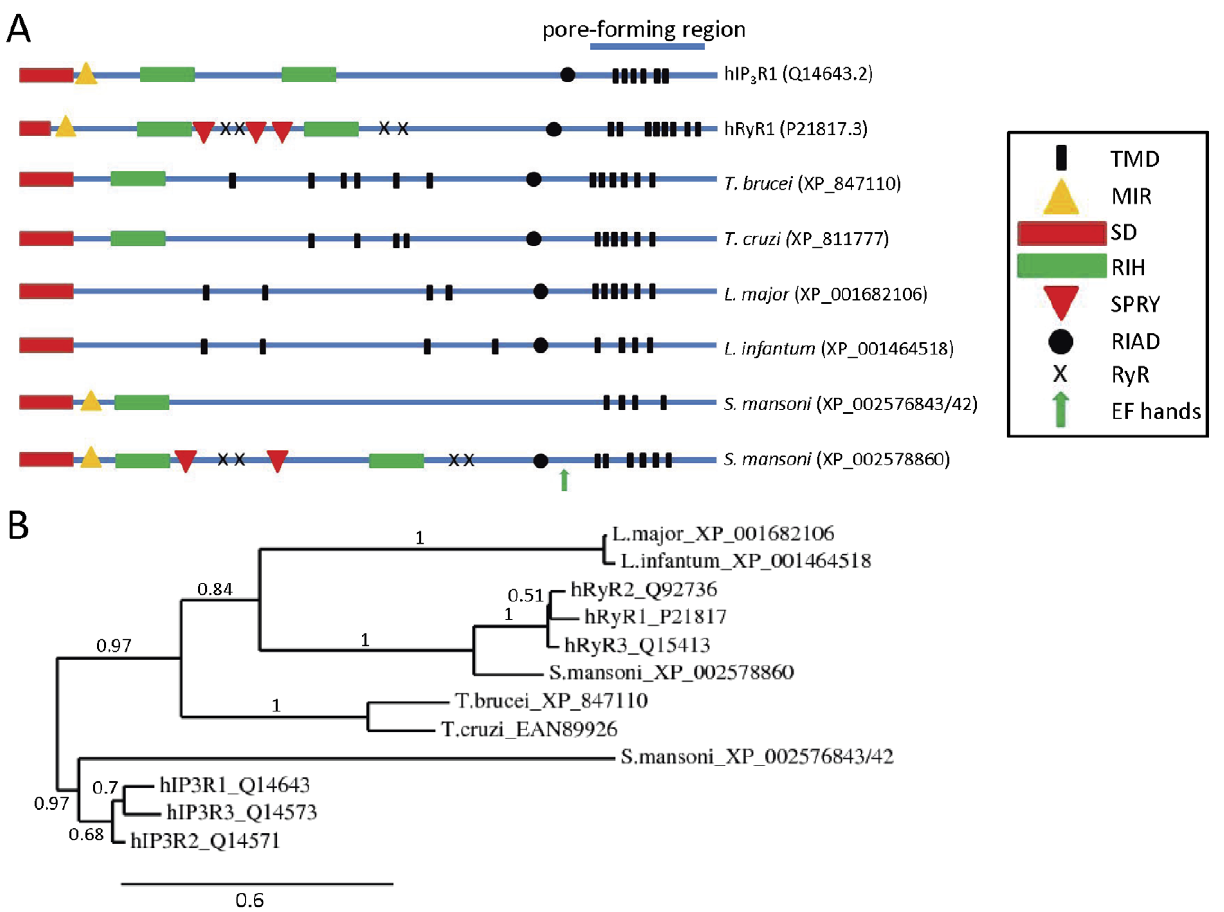
Figure 2. Comparison of full-length sequences of human and parasite IP 3 R/RyR homologues. (A) Schematic showing location of putative transmembrane domains (TMDs) and conserved domains identified using the Conserved Domains Database (NCBI), including: MIR (mannosyltransferase, IP 3 R and RyR) domains (pfam02815), RIH (RyR and IP 3 R homology) domains (pfam01365), RIH-associated domains (RIAD) (pfam08454), EF hands, suppressor-domain-like domains (SD) (pfam08709), RyR (ryanodine receptor) domains (pfam02026), and SPRY (SPla and the ryanodine receptor) domains (pfam00622). Putative pore-forming regions (pfam00520) are also indicated. (B) Phylogram showing relationships between full-length sequences of human and parasite IP 3 R/RyR homologues (see Methods: based on 226 high confidence positions from a multiple sequence alignment; gamma shape parameter 1.755; proportion of invariant sites 0) . Branch length scale bar and branch support values are shown.